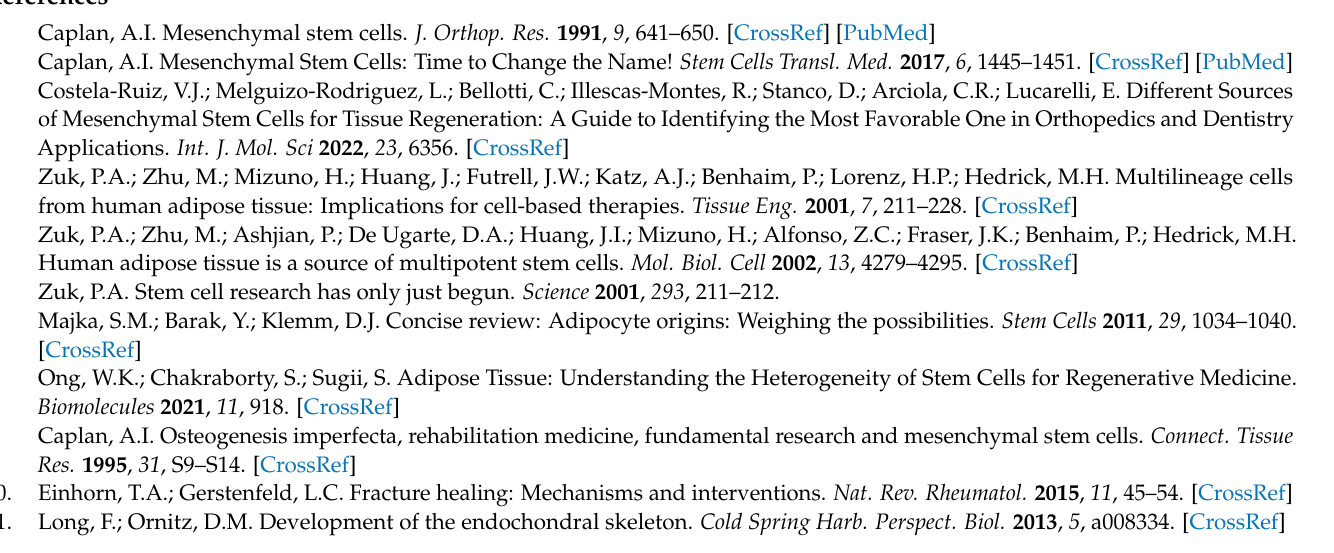
Figure S3: SEM-EDX spectrum analysis of unstimulated and osteogenically stimulated adMSC in 3D spheroid cultures after 14 and 28 days of cultivation; Table S1: Quantification of bone metabolism- affecting factors in cell culture supernatants and lysates from unstimulated (US) and osteogenic (OS) stimulated 2D and 3D